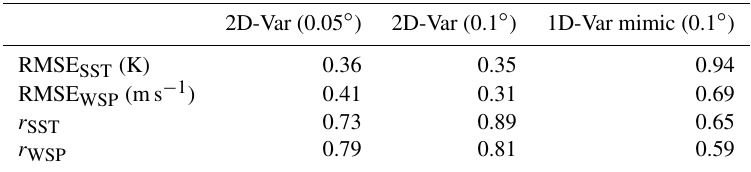
Figure 10. As with Fig. 3 but with no spatial correlations accounted for in S a and a “pencil beam” forward model at each bore sight (i.e. no accounting for antenna pattern) to approximate a series of 1D-Var retrievals. Table 3. Root mean squared error (RMSE) and correlation coefficients ( r ) of retrieved versus true values for SST and WSP. Three different realisations of the retrieval are presented for the synthetic scene. Only grid points within the observation area are used in the calculations. The retrieval grid resolutions are given in parentheses – see text for